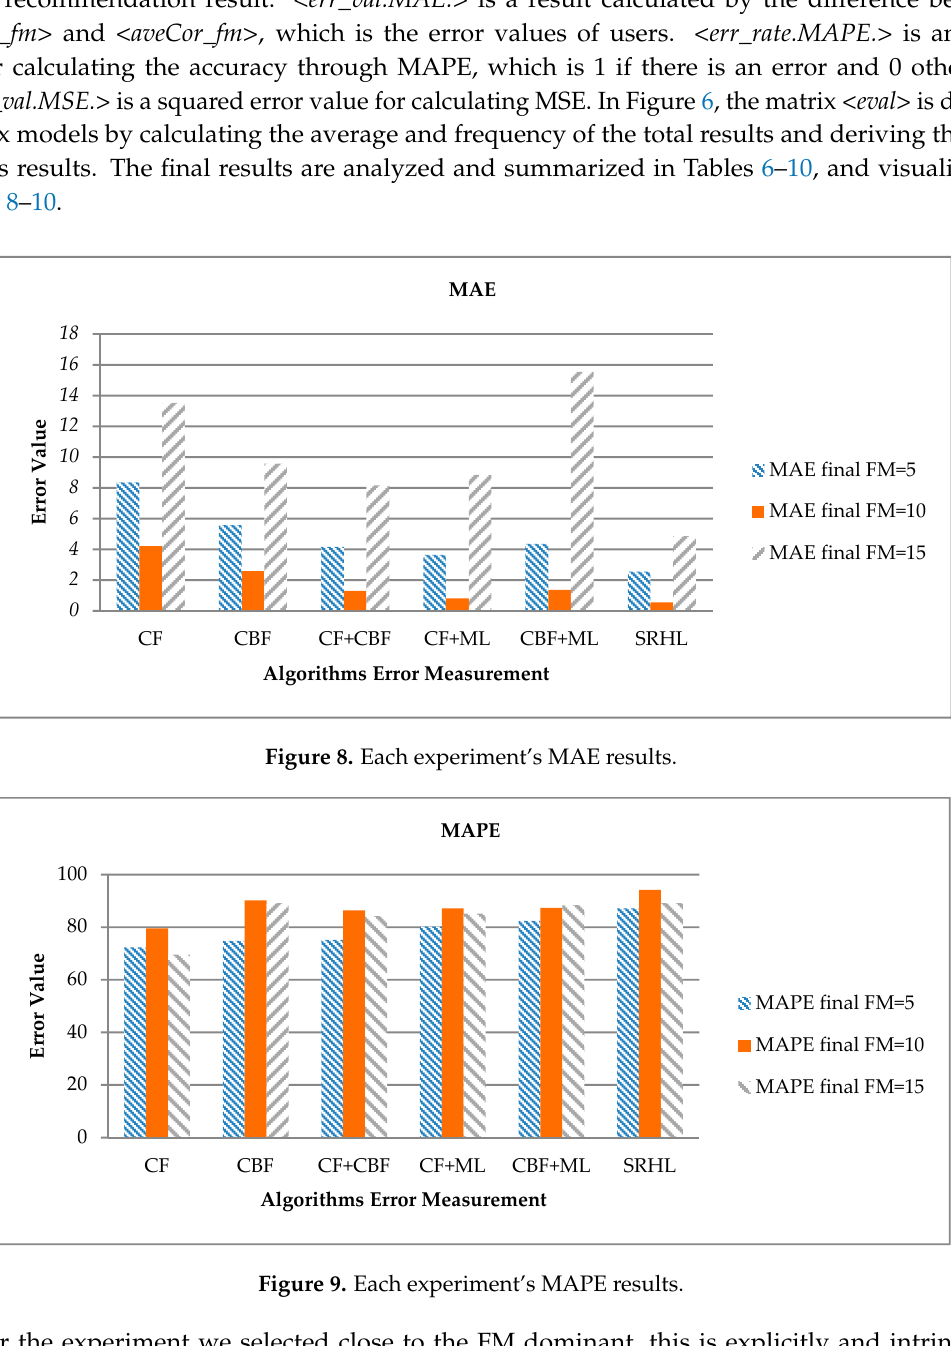
14 of 21 Figure 7. Screenshot of results of MAE, MAPE, and MSE in R. Table 5. R library for analysis and prediction of experiments. Analysis Method